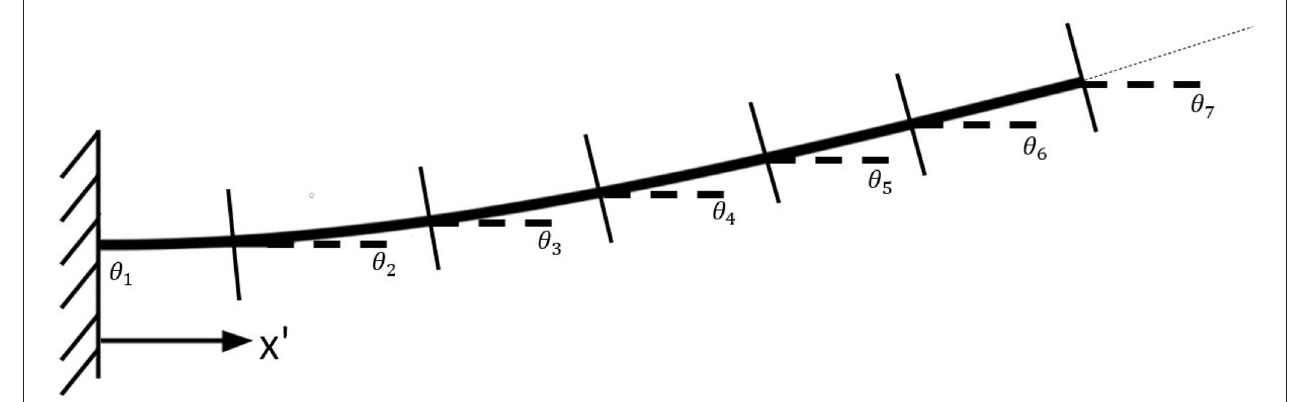
FIGURE 6 | Illustration of the method used for adapting a continuous bending model to a Piece-wise Constant Curvature model.